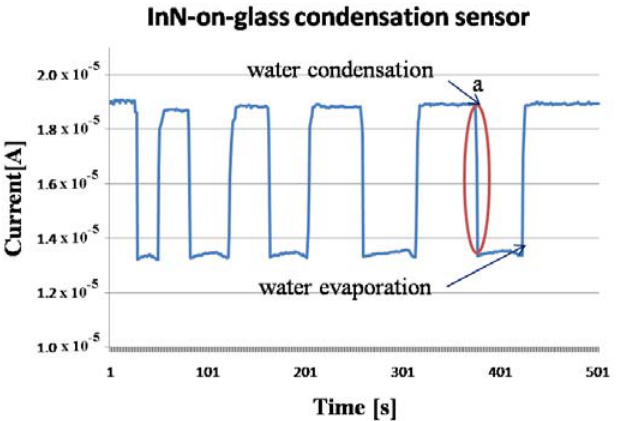
Figure 8. InN-on-glass condensation sensor signal at rapid water condensation and evaporation on its surface. Region a is detailed in Figure